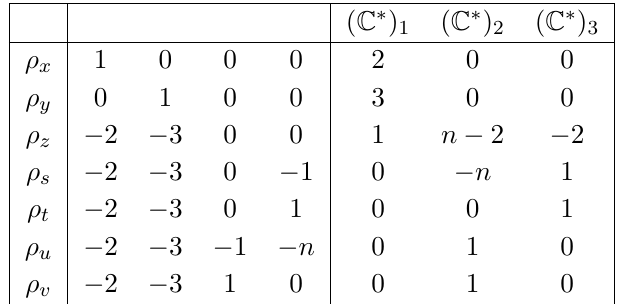
Table 3 . Toric data for P 1 ; 2 ; 3 ( O (cid:8) 2 K F